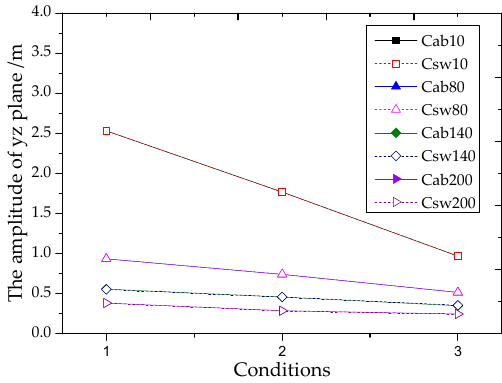
Figure 11. Amplitude change with conditions.